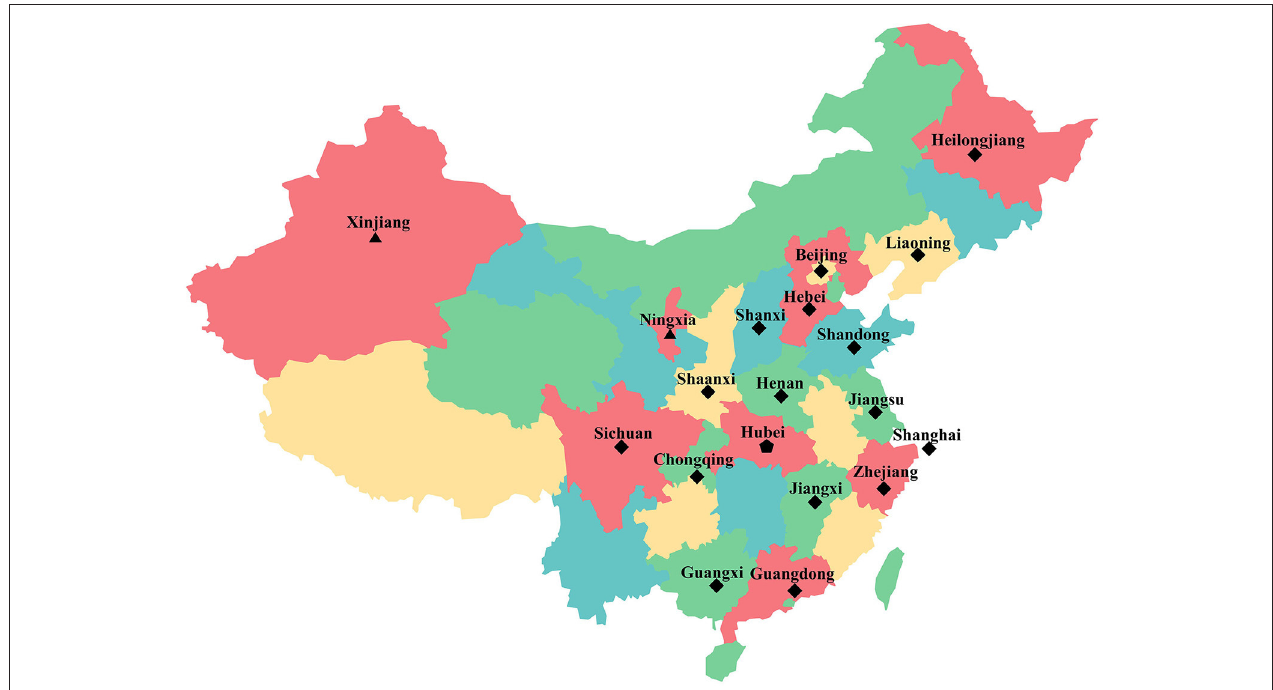
FIGURE 1 | Geographic distribution of samples provinces/municipalities. The symbol represents the provinces/municipalities of different COVID-19 pandemic severity. represents the pandemic severity was high. represents the pandemic severity was moderate.